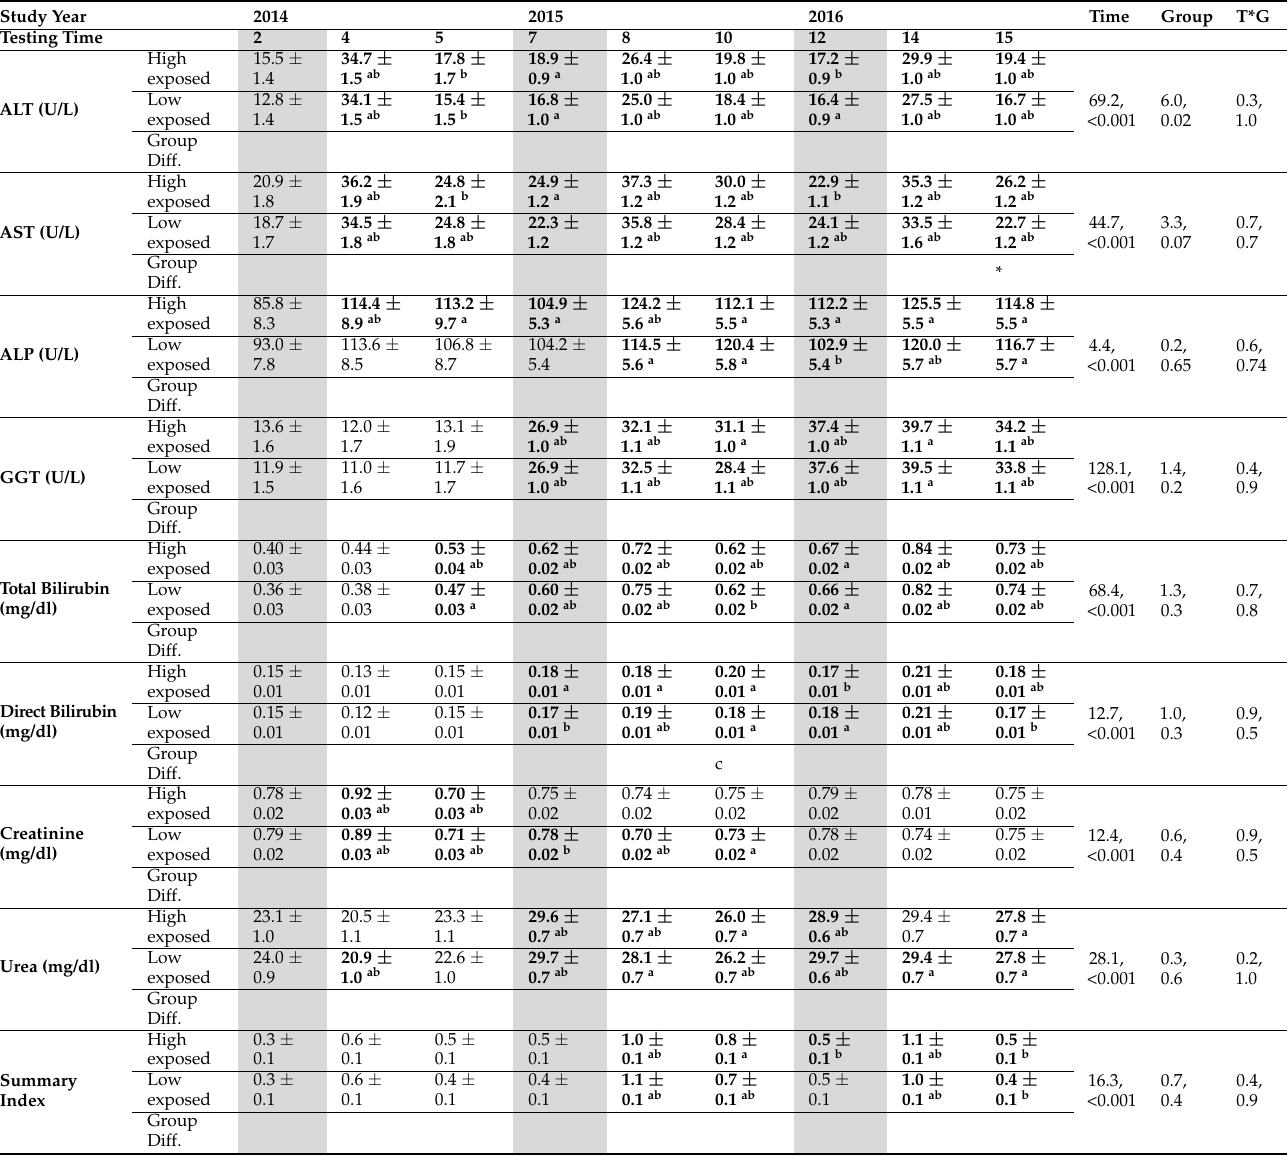
Table 4. Liver and kidney function measures (least squares mean ± SE) of the high and low CPF exposure groups using repeated mixed-effects models and the relationship with the covariates of time, group, and the interaction of time and